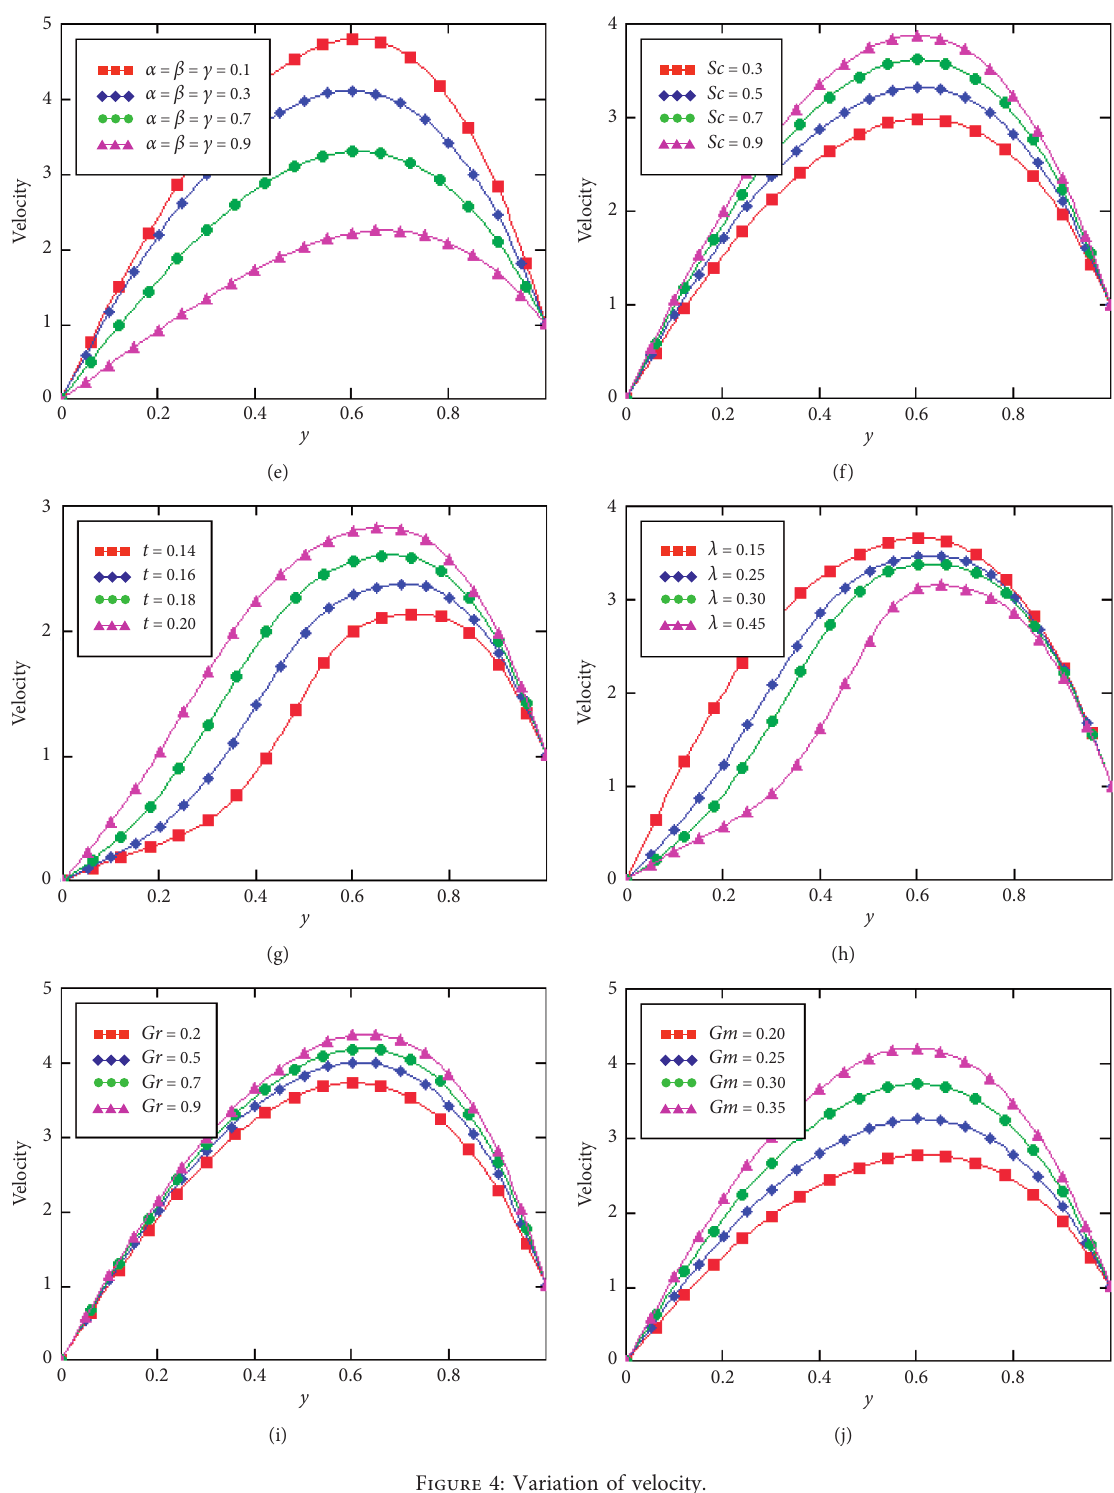
Figure 4: Variation of